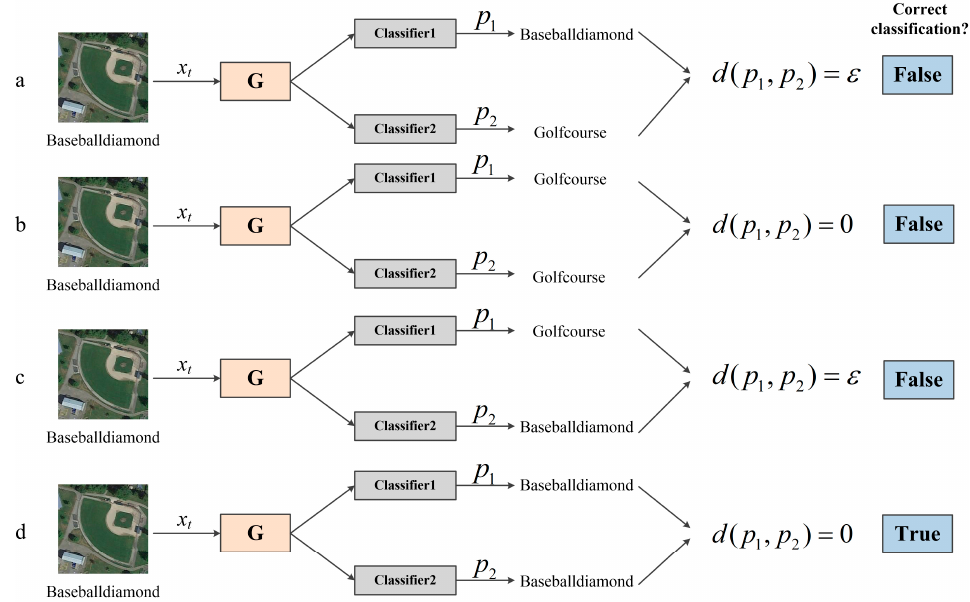
Figure 4. Conditions for a target sample with 2 classifiers for predictions to calculate discrepancy. Condition ( a – c ) are incorrect distinctions, and ( b ) is a distortion which reduces the accuracy of the discrepancy. Condition ( d ) can be considered the only correct distinction for this target sample.